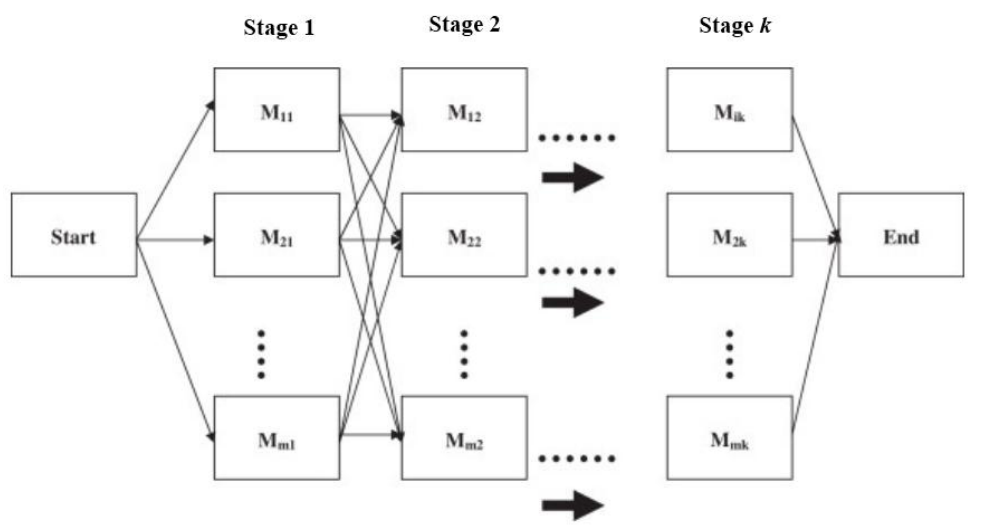
Figure 1. A Schematic of Hybrid Flowshop Model.